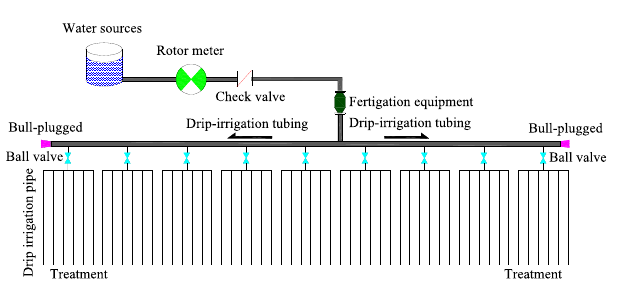
Figure 5. A drip irrigation system consisting of a rotor metre, check valve, drip fertigation equipment, drip irrigation tubing, ball valve, and drip irrigation